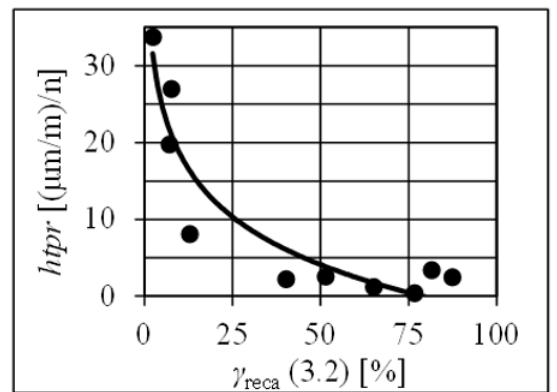
Figure 5. Relationship between high temperature performance ratio of AC 16 asphalt mixes and average recoverable strain of different binders